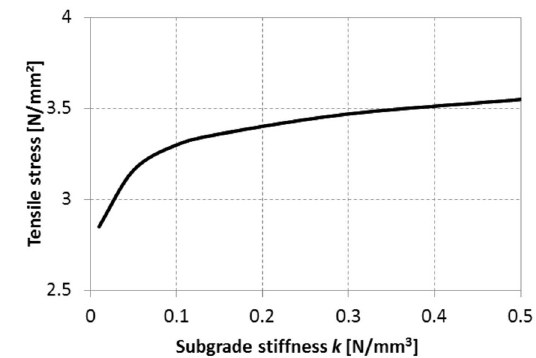
Figure 24. Effect of subgrade stiffness on the principal tensile stress.